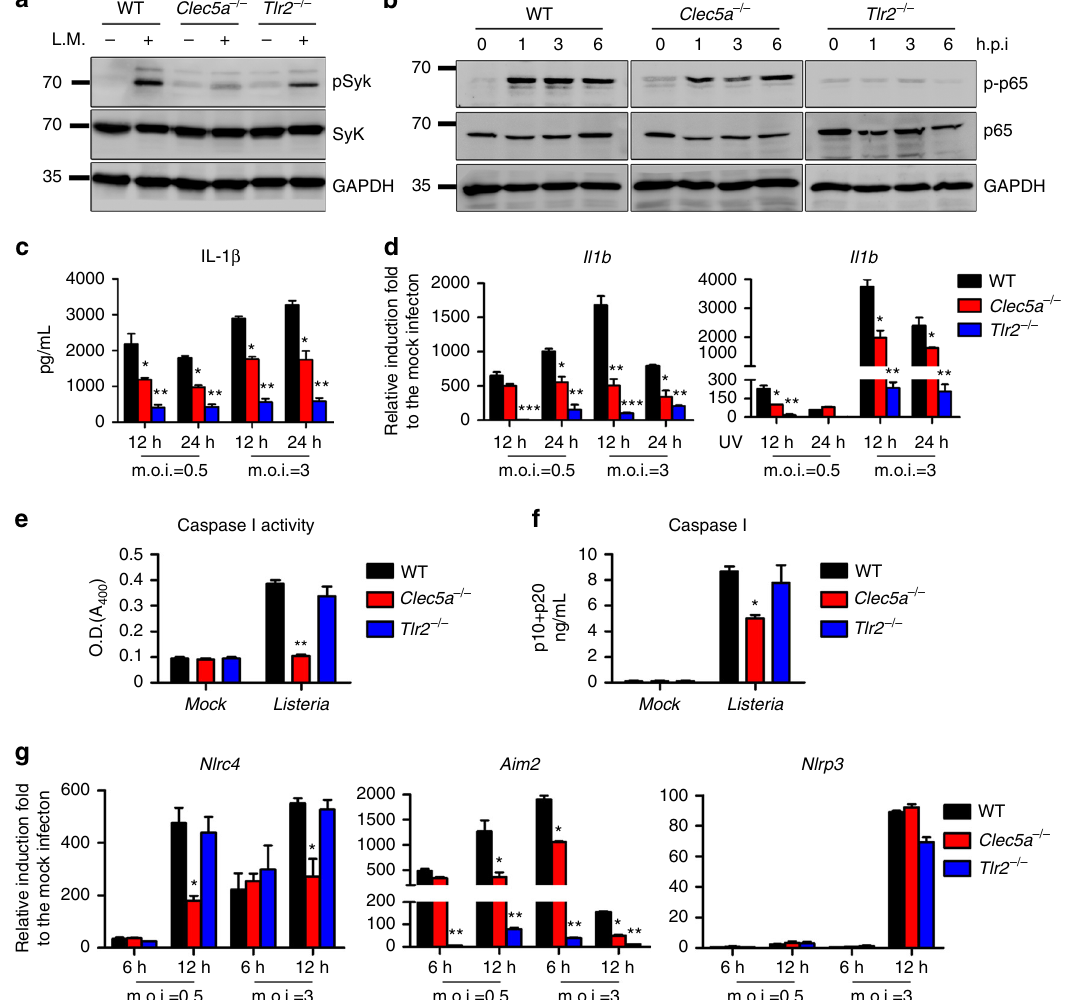
Fig. 1 CLEC5A is involved in L. monocytogenes -induced IL-1 β production. Mouse macrophages were incubated with live L. monocytogenes (MOI 10) and lysates were collected at 60 min post infection to detect a Phospho-Syk, while b phospho-NF κ B p65 were detected at indicated time points. c Mouse macrophages were incubated with live L. monocytogenes , supernatants were collectedand IL-1 β secretion was measured by ELISA. d Mouse macrophages incubated with live (left ) or UV-inactivated L. monocytogenes were collected6 and 12 h post infection to detect Il1b transcripts by RT-qPCR. e Caspase-1 activity in mouse macrophages (6 h post Listeria infection) was presented as absorbance at 405 nm ( A 405 ). f The amounts of caspase-1 p10 and p20 released from macrophages were determined by ELISA at 12 h post L. monocytogenes infection. g Mouse macrophages incubated with live L. monocytogenes were collected to detect Nrlp3, Aim2 , and Nlrc4 transcripts by RT-qPCR. All the data were collected and expressed as mean ± s.e.m. from at least three independent experiments. One-way ANOVA was performed. * P < 0.05, ** P < 0.01; for treated versus control or knockout versus wild-type